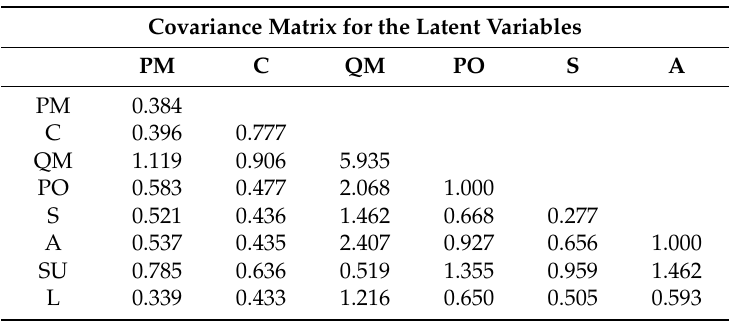
Table 4. Covariance matrix for the latent variables.